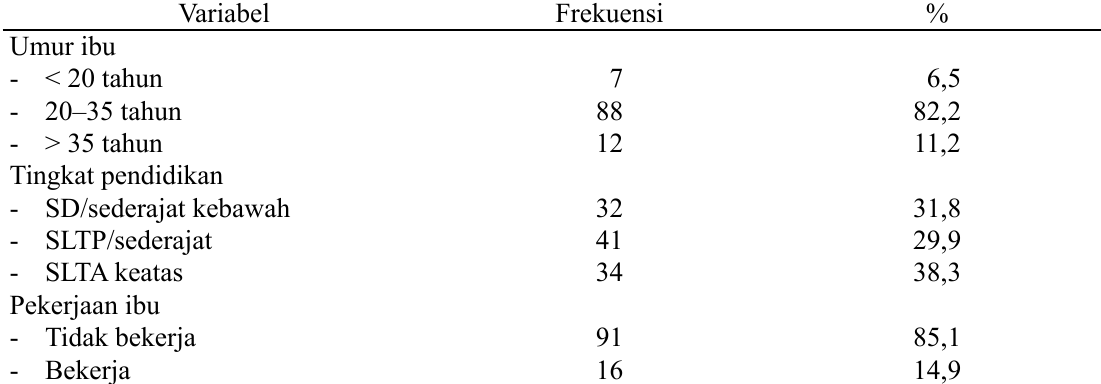
Tabel 2. Karakteristik ibu responden penelitian (N = 107)